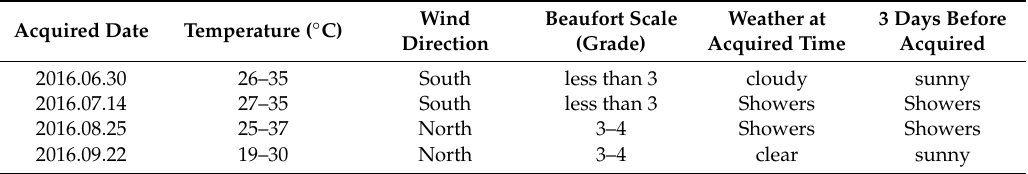
Table 2. Weather conditions of the polarimetric SAR images at acquired time and 3 days before acquired